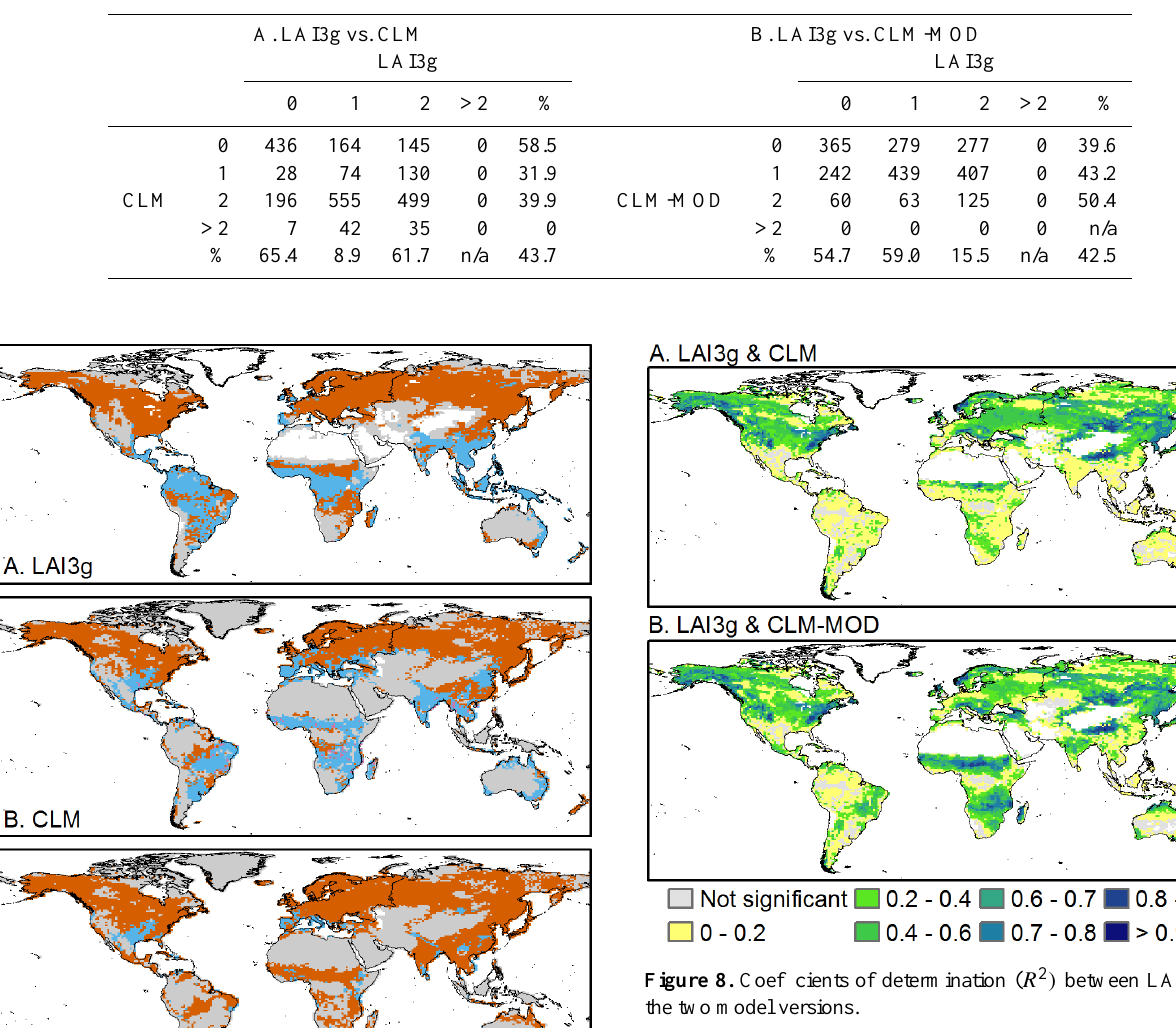
Table 3. Confusion matrices comparing grid cell peak counts between LAI3g and the two model data sets. “%” rows and columns are the percent of the correct values (diagonal) compared to the sums for the respective rows and columns. n/a is not applicable.